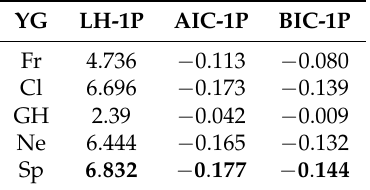
Table 7. Loglikelihood, AIC and BIC values for the young generation, 1P-copulas.